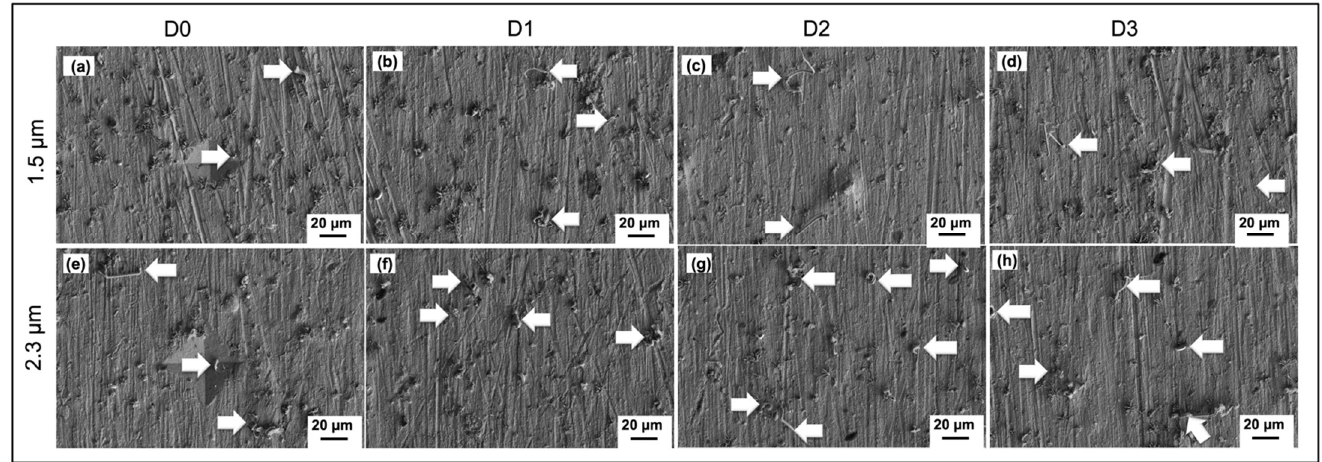
Figure 8. FESEM micrograph on the whiskers’ formation after 52 weeks stored under 30 °C/60% RH at a certain distance from the indented point for 1.5 µm ( a – d ) and 2.3 µm ( e – h ) coatings of the immersion tin surface finish (refer to Figure 7 for regions D0, D1, D2, and D3).